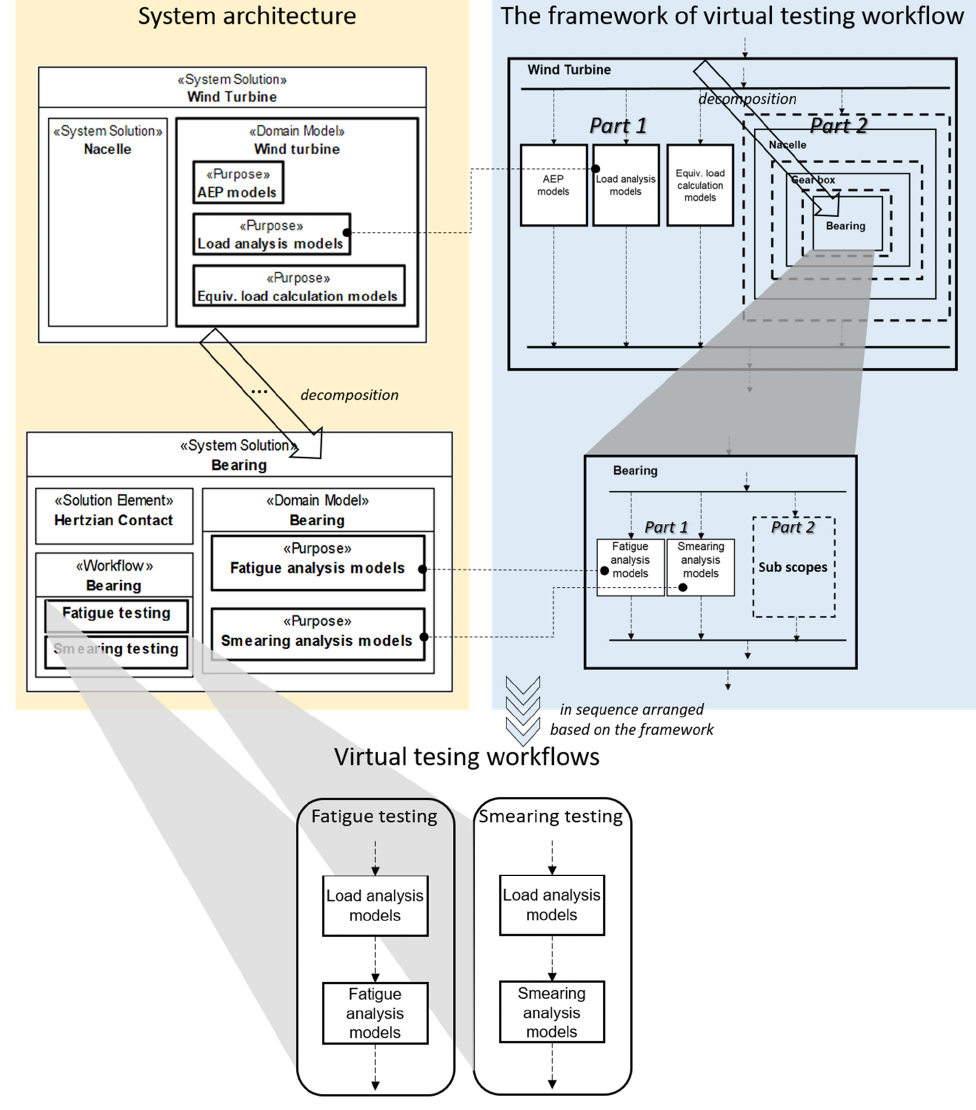
Figure 7. The nested framework of virtual testing workflows corresponding to the hierarchical system scopes.